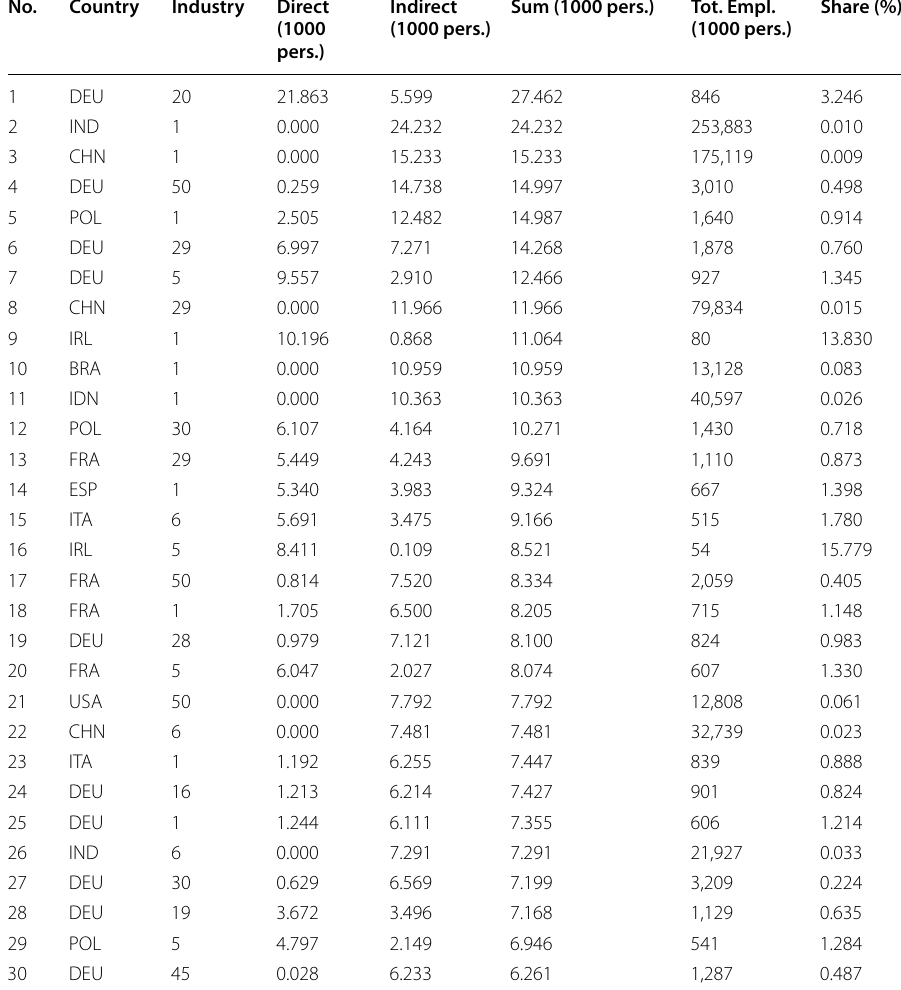
Ordered by absolute employment effect. Source: World Input–Output Database, data for 2014, own